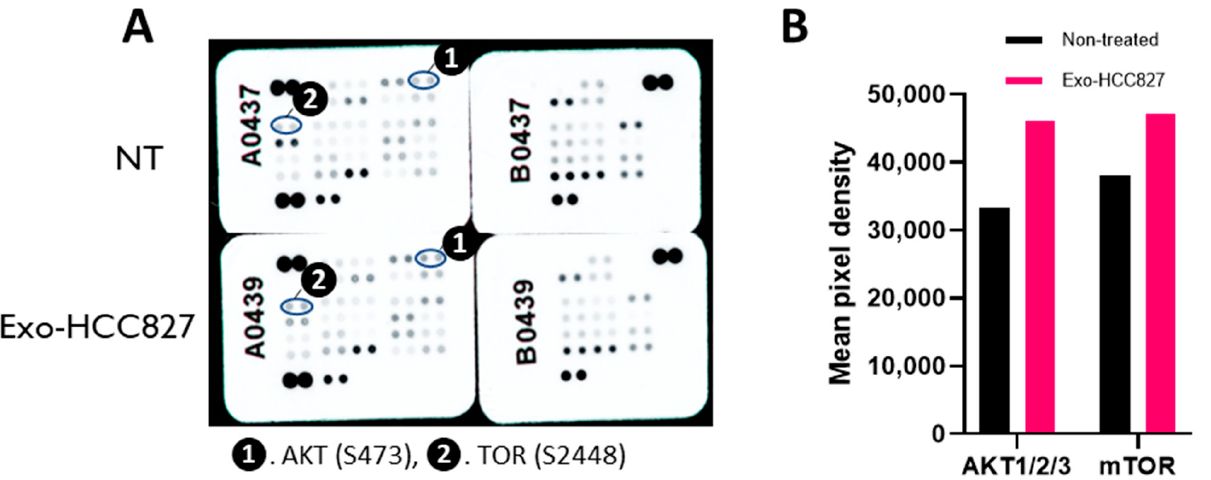
lated from HCC827 supernatant. Circled spots indicated positive signal for ❶ AKT (S473) and ❷ . ❶ TOR (S2448) ( B ) Quantification of the relative levels of the phosphorylation of indicated kinases.